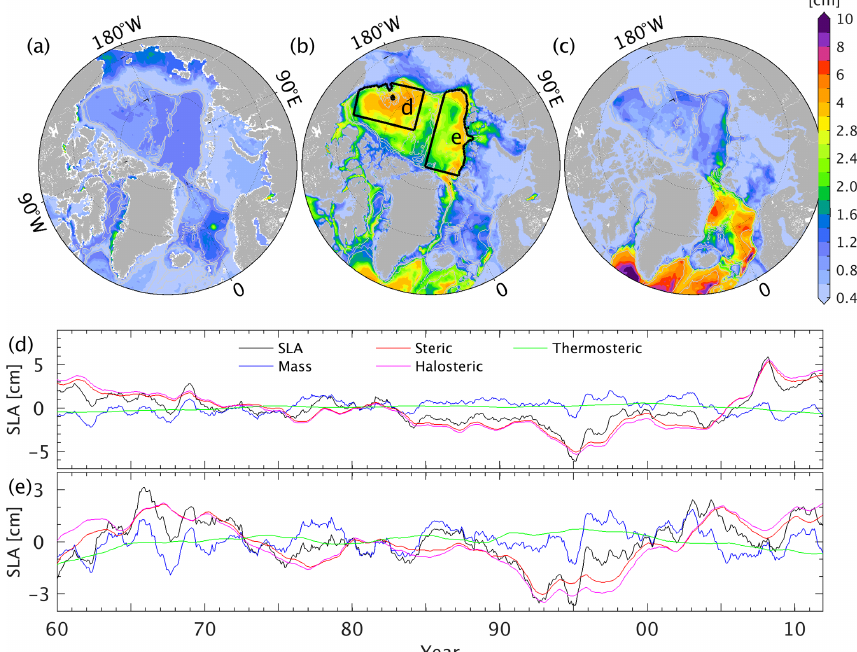
Figure 10. The rms variability at the decadal period of (a) bottom pressure anomaly, (b) the halosteric component, and (c) the thermosteric component. Panels (d) and (e) show the time series of sea level anomaly and mass, steric, and thermo-/halosteric components in the Canadian and the Eurasian basins (see the regions in panel b ), respectively. Linear trends in all the time series are removed in panels (d) and (e) .